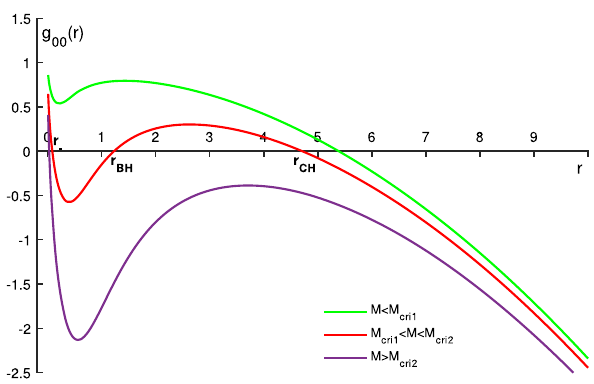
Fig. 3 Plot of g 00 ( r ) versus r for the asymptotically ds EGB black hole. Purple line: M > M cri 2 , Red line: M cri 1 < M < M cri 2 , Green line: M < M cri 1 . Plot depicted with α = 0 . 1 and (cid:5) = 0 . 1. For a finite range of the mass, there are three horizons: the inner horizon ( r − ), the black hole horizon ( r BH ) and the cosmological horizon ( r CH )